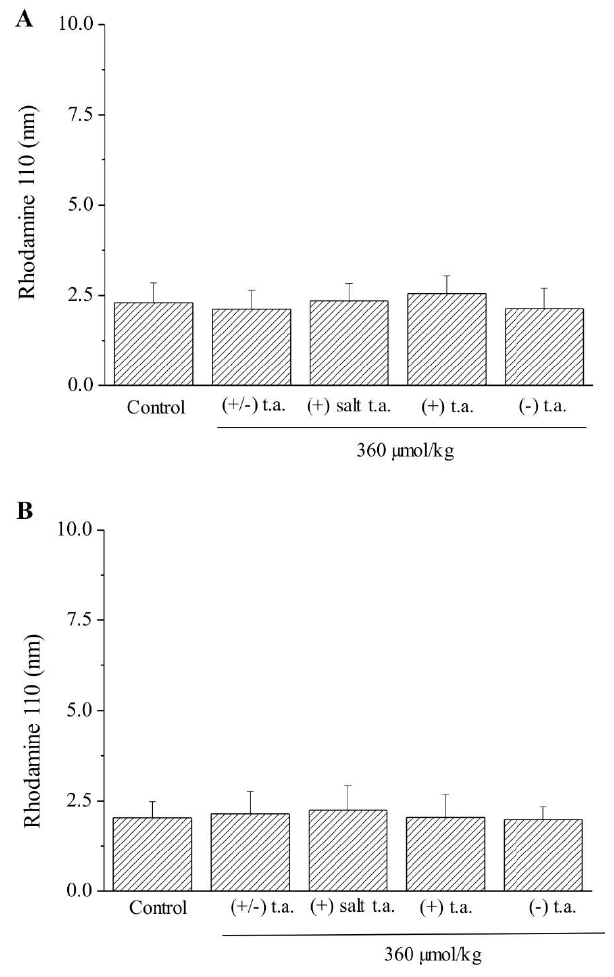
Figure A2. Subchronic toxicity treatments: caspase-3 activity in liver and skeletal muscle. Effects of 15-day subchronic toxicity treatments with 360 µmol/kg (+/−) t.a., (+) salt t.a., (+) t.a., (−) t.a. on enzymatic activity of Caspase-3 in liver ( A ) and skeletal muscle ( B ). The amount of cleaved rhodamine 110 substrate was measured by excitation at 496 nm and emission at 520 nm. Each value represents the mean ± SEM of 6 rats per group.